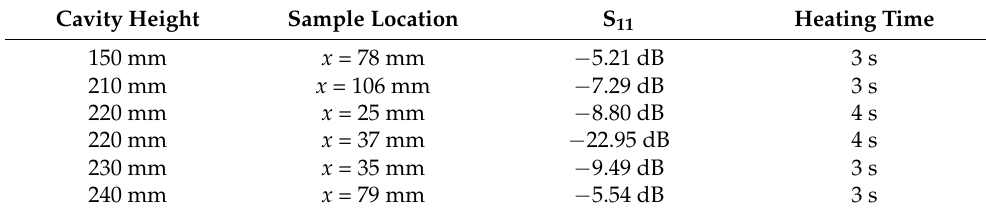
Table 5. The select heating locations and heating time of beef.